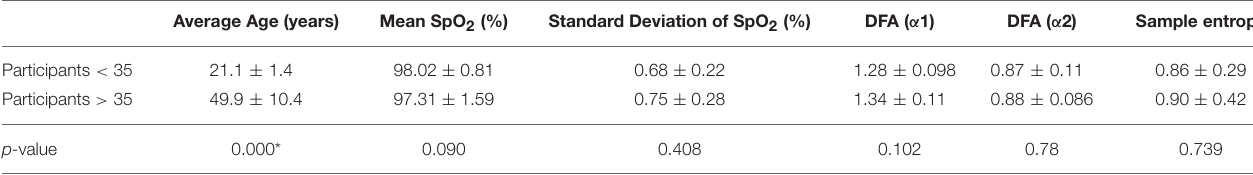
TABLE 2 | The effect of age on the measures of SpO 2.